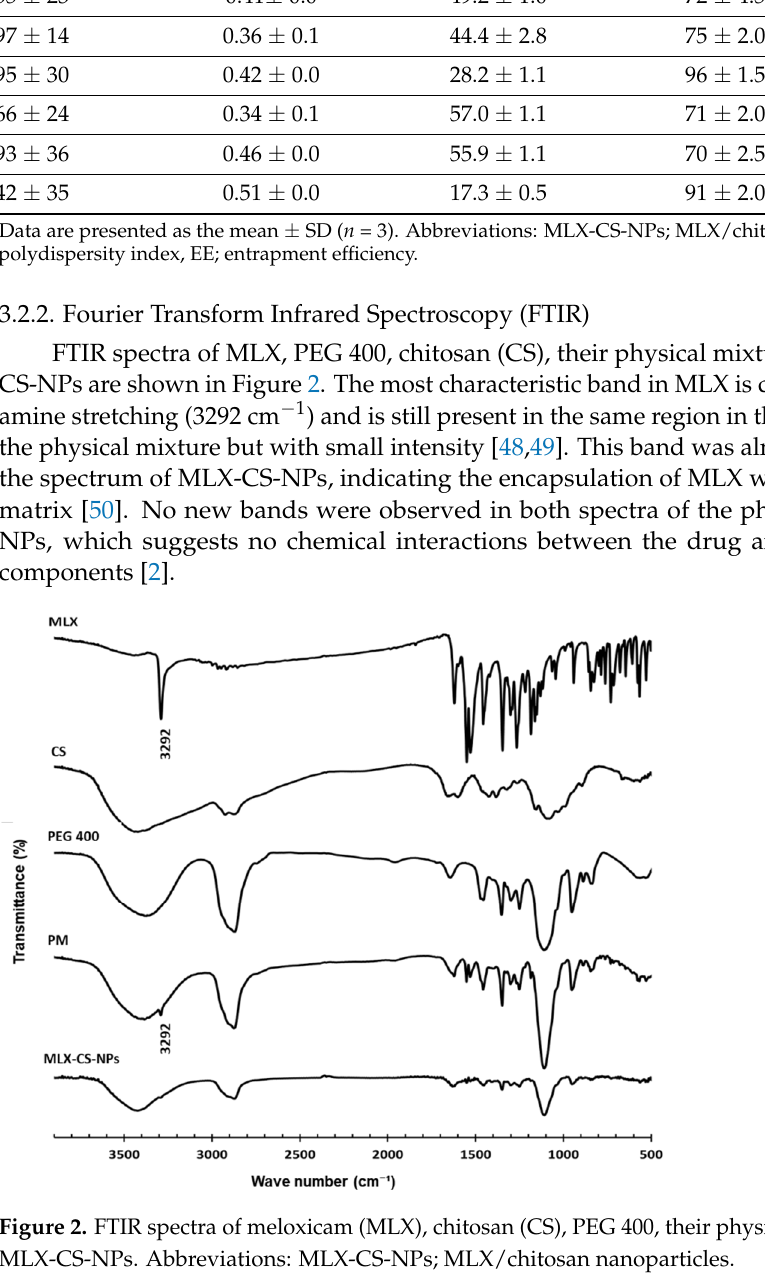
Figure 3. In vitro release profile of MLX-CS-NPs dispersion and MLX solution in PEG 400 using PBS (pH 7.4) as the release medium. Data are presented as the mean ± SD ( n = 3). Abbreviations: MLX- CS-NPs; MLX/chitosan nanoparticles.